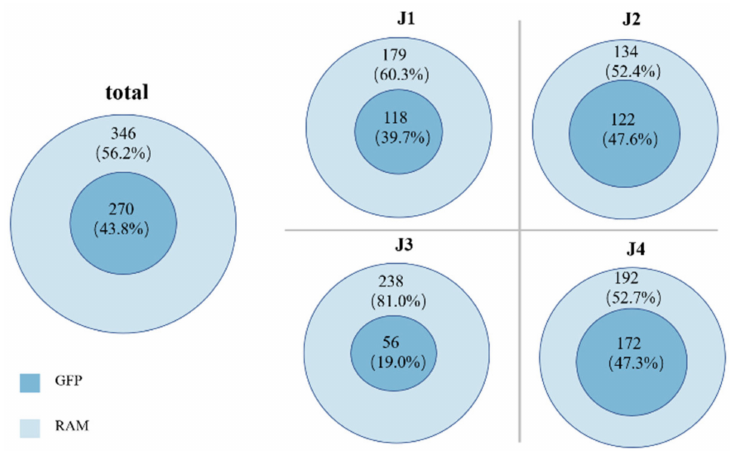
Figure 4. NMDS analysis of differences in bacterial community composition at four stages under two methods.